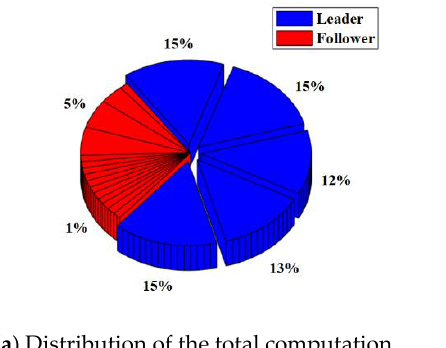
Figure 13. Resource occupation of the RIPPLE algorithm with malicious nodes.